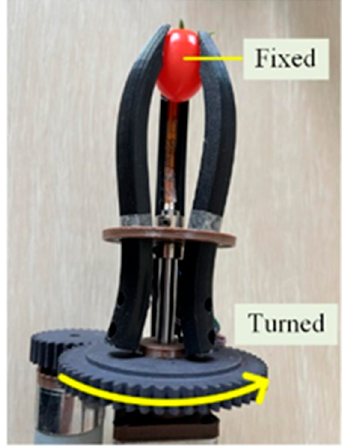
Figure 11. Experiment of grabbing fruit.